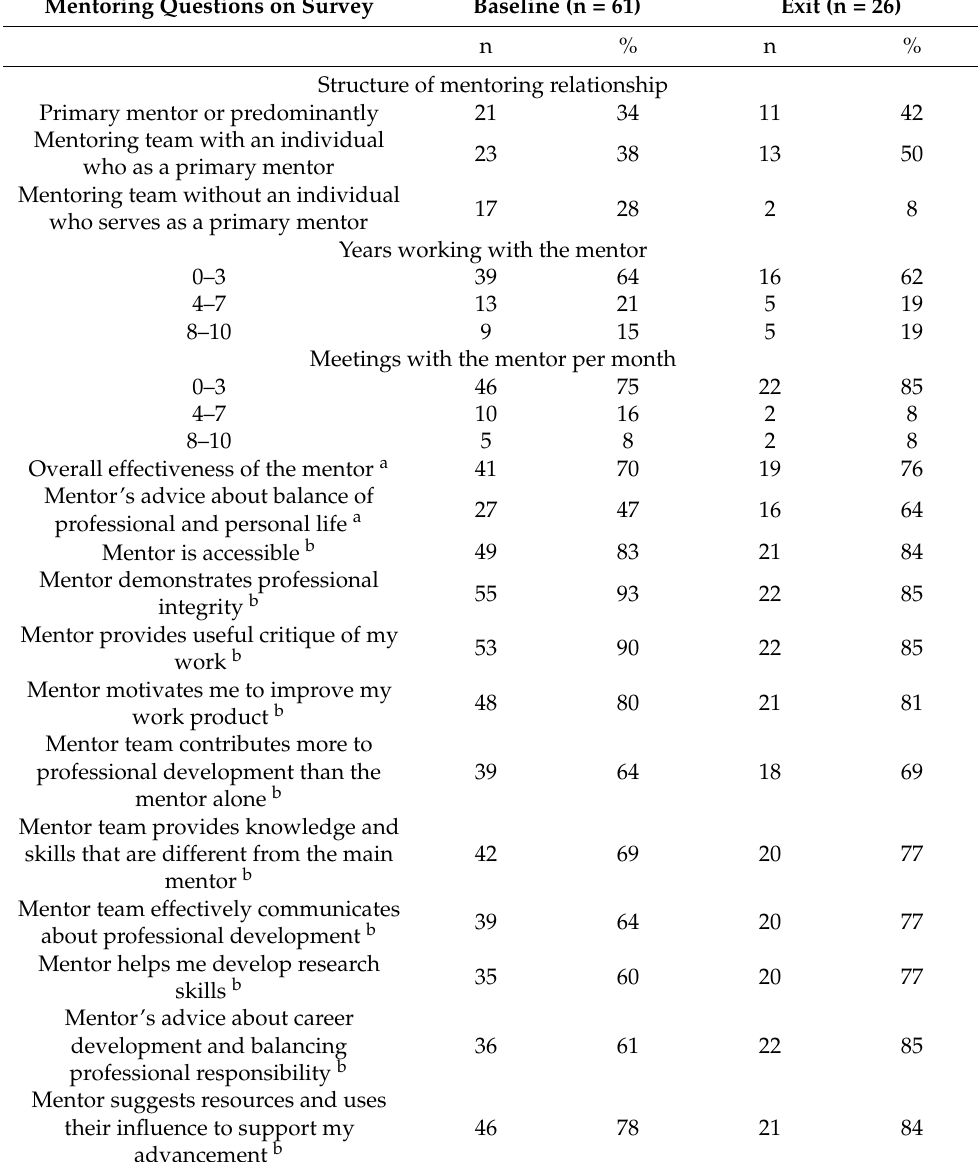
Table 2. Mentoring structure, characteristics, and effectiveness of mentors and mentoring teams taken from baseline and exit surveys completed by participating